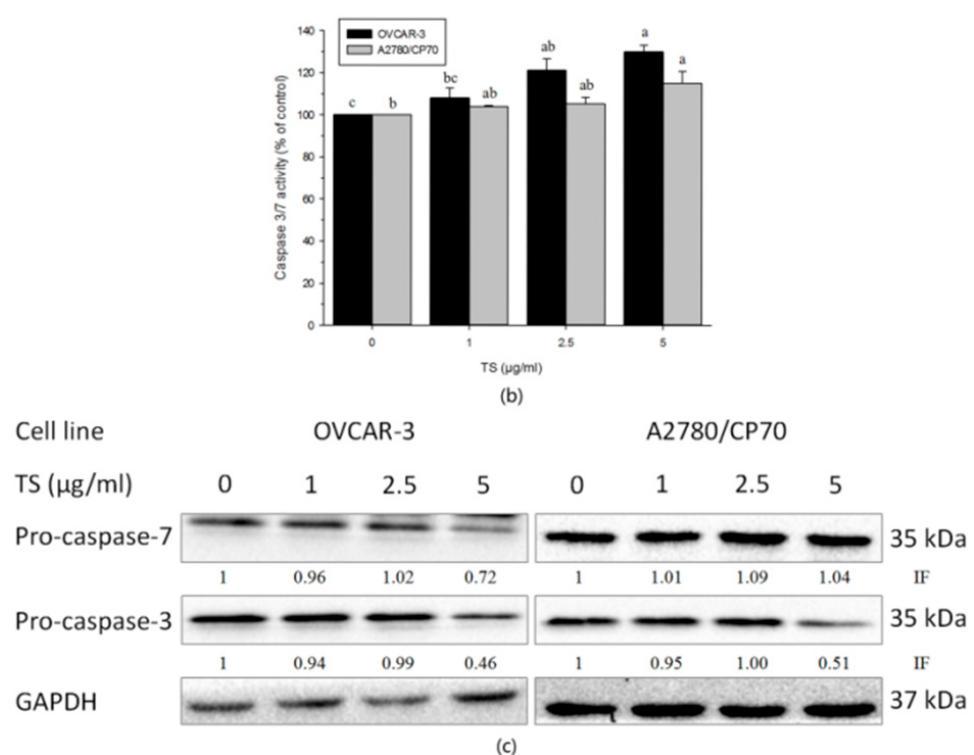
Figure 2. Apoptosis-inducing effects of TS on OVCAR-3 and A2780/CP70 cells. ( a ) Hoechst 33342 staining of OVCAR-3 and A2780/CP70 cells after treatment with 0 to 5 µ g/mL TS for 24 h via fluorescent microscopy (200 × ). Intact nuclei represents viable cells and highly condensed or fragmented nuclei represent apoptotic cells; ( b ) Caspase-3/7 activity levels after TS treatment (0 to 5 µ g/mL) for 24 h. The caspase-3/7 activity of control group was arbitrarily expressed as 100%; ( c ) Protein expression levels of pro-caspase-3 and -7 determined by Western blotting assay. Data represents mean ± SD of three independent experiments. Lower case letters (a, b, etc.) mean significant differences among different treatments ( p < 0.01). “IF” means impact factor and represents the Western blotting signals were quantified and normalized to the loading control GAPDH.